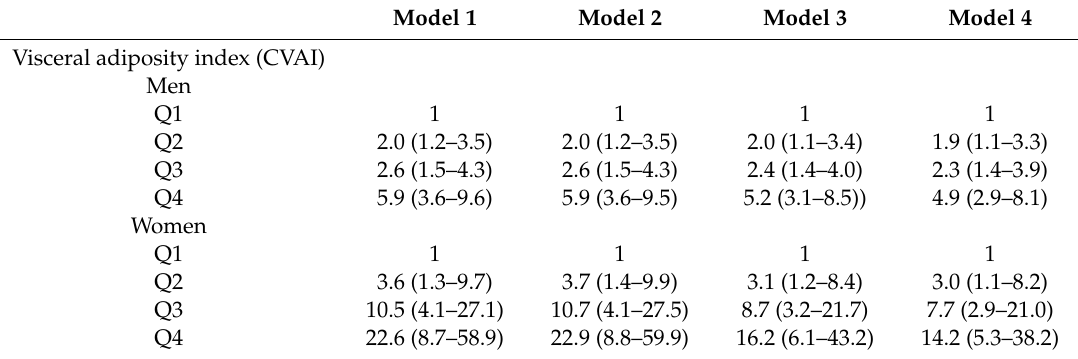
Table 4. Adjusted odds ratios (ORs) and 95% CI of the visceral adiposity index and body shape index with diabetes risk in adults in